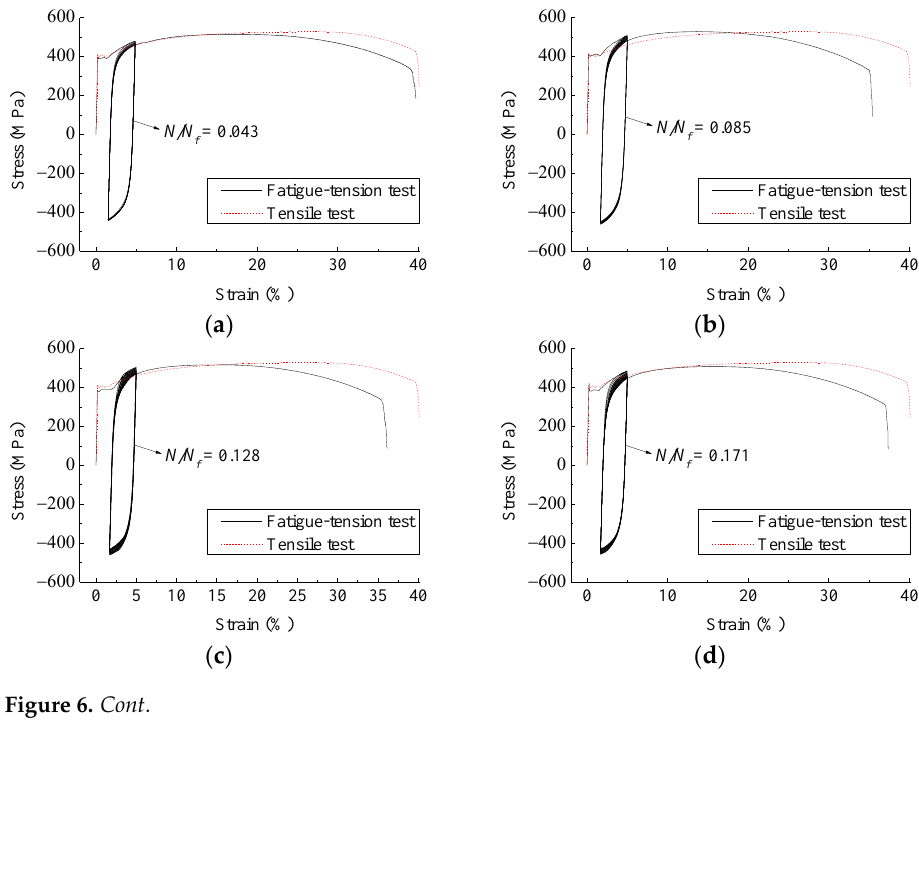
Figure 5. Stabilized cyclic stress – strain hysteretic loops in low-cycle fatigue tests.